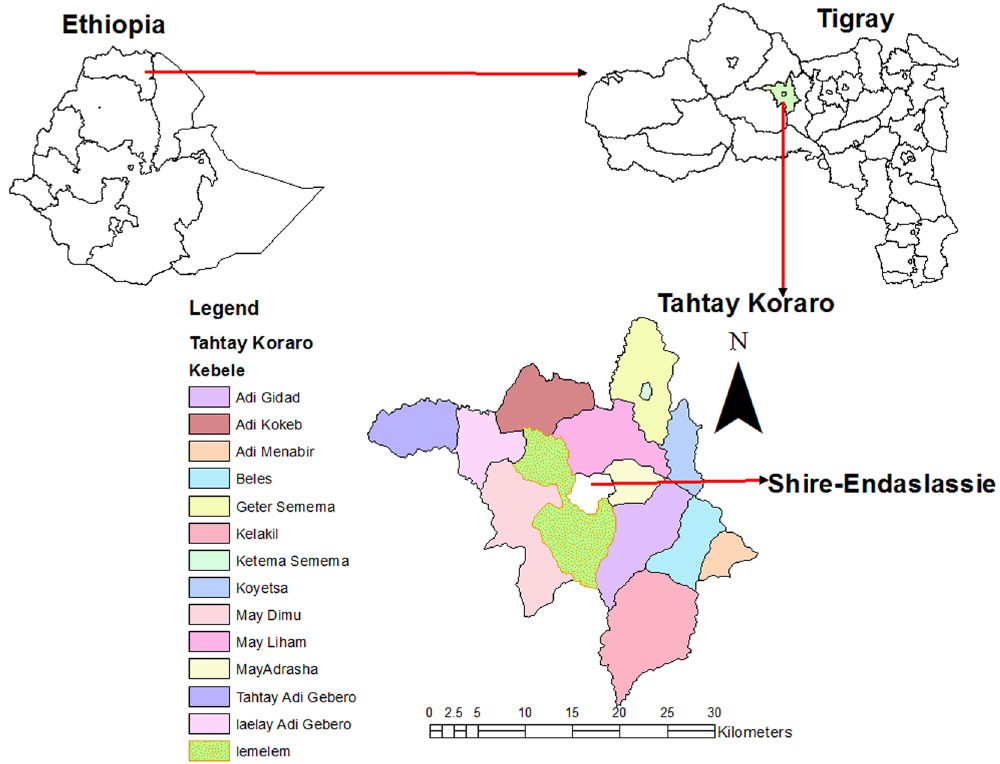
Figure 1. Geographical location of the study area; Tahtay Koraro district, in Tigray Regional State, Northern